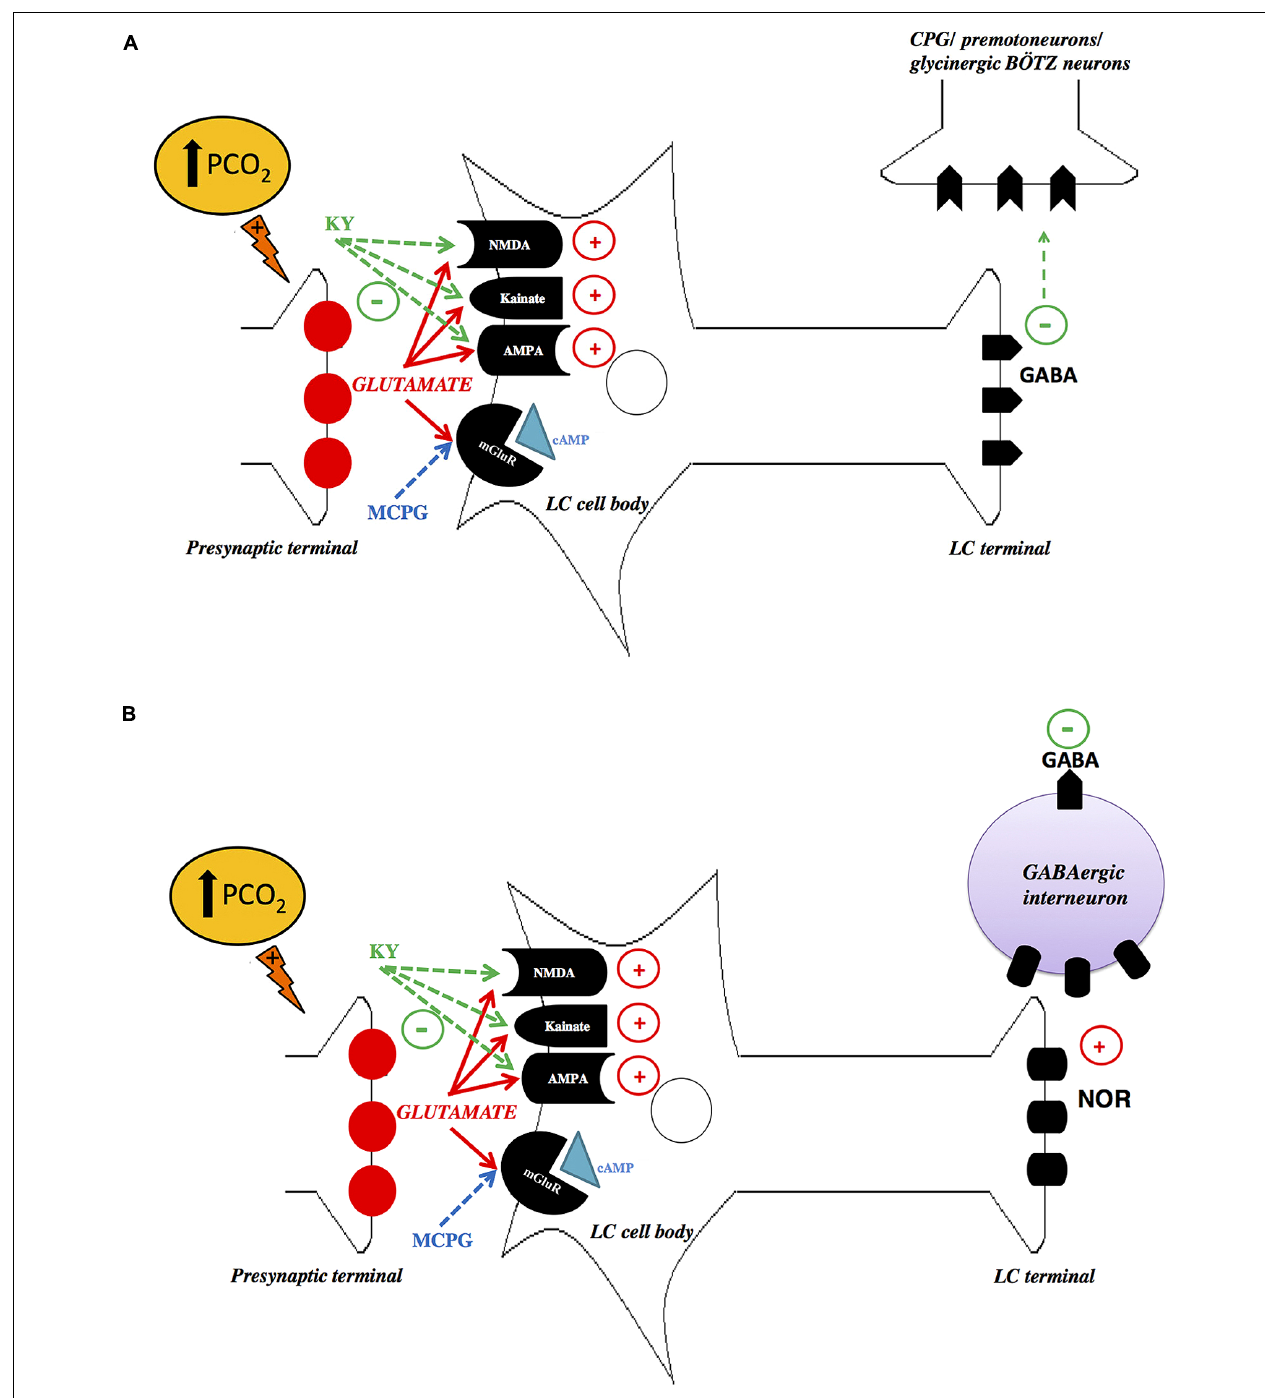
activates noradrenergic neurons that induce GABA release. Inhibition of NMDA, AMPA and Kainate receptors by KY may decrease the release of excitatory neurotransmitter of LC, probably noradrenaline (NOR), leading to inhibition of GABAergic interneuron, which in turn may reduce the activation of the glycinergic Bötzinger (BÖTZ) neurons, causing an increase in the hypercapnic ventilatory response. LC, locus coeruleus; PGC, nucleus paragigantocellularis; KY, kynurenic acid; MCPG, α -methyl-4-carboxyphenylglycine. With permission from Wiley Online Library (Taxini etal.,